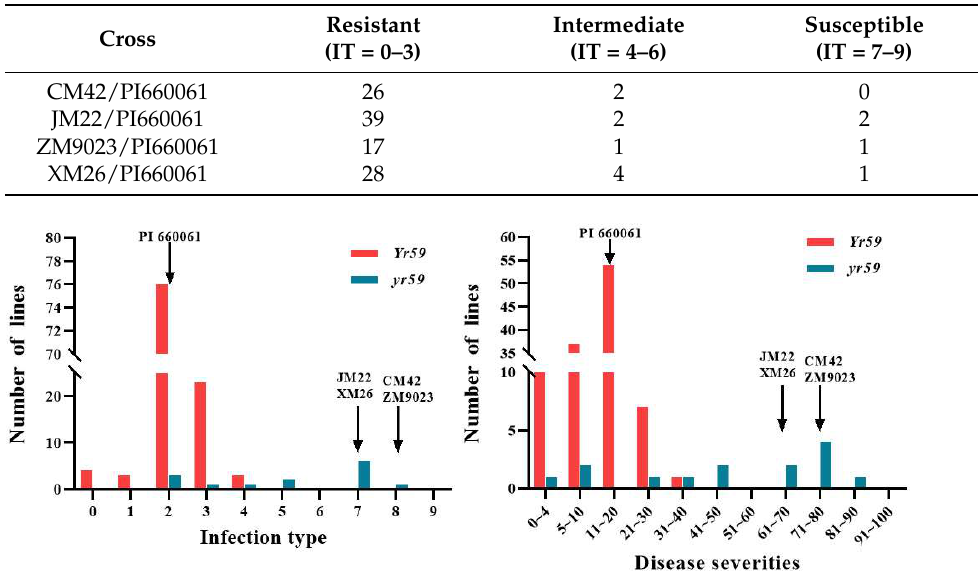
Figure 3. Distributions of mean infection type (IT) and disease severity (DS) for 123 Introgression Lines (ILs) from the four crosses of CM42///CM42//CM42/PI660061, JM22///JM22//JM22/PI660061, ZM9023///ZM9023//ZM9023/PI660061 and XM26///XM26//XM26/PI660061 at Yangling (YL) and Mianyang (MY) in 2019–2021. Arrows indicate the scores of the parental lines. Table 3. Numbers of introgression lines of the four crosses classified in the resistant, intermediate and susceptible categories in the light of mean infection types (IT) over two years and three locations.